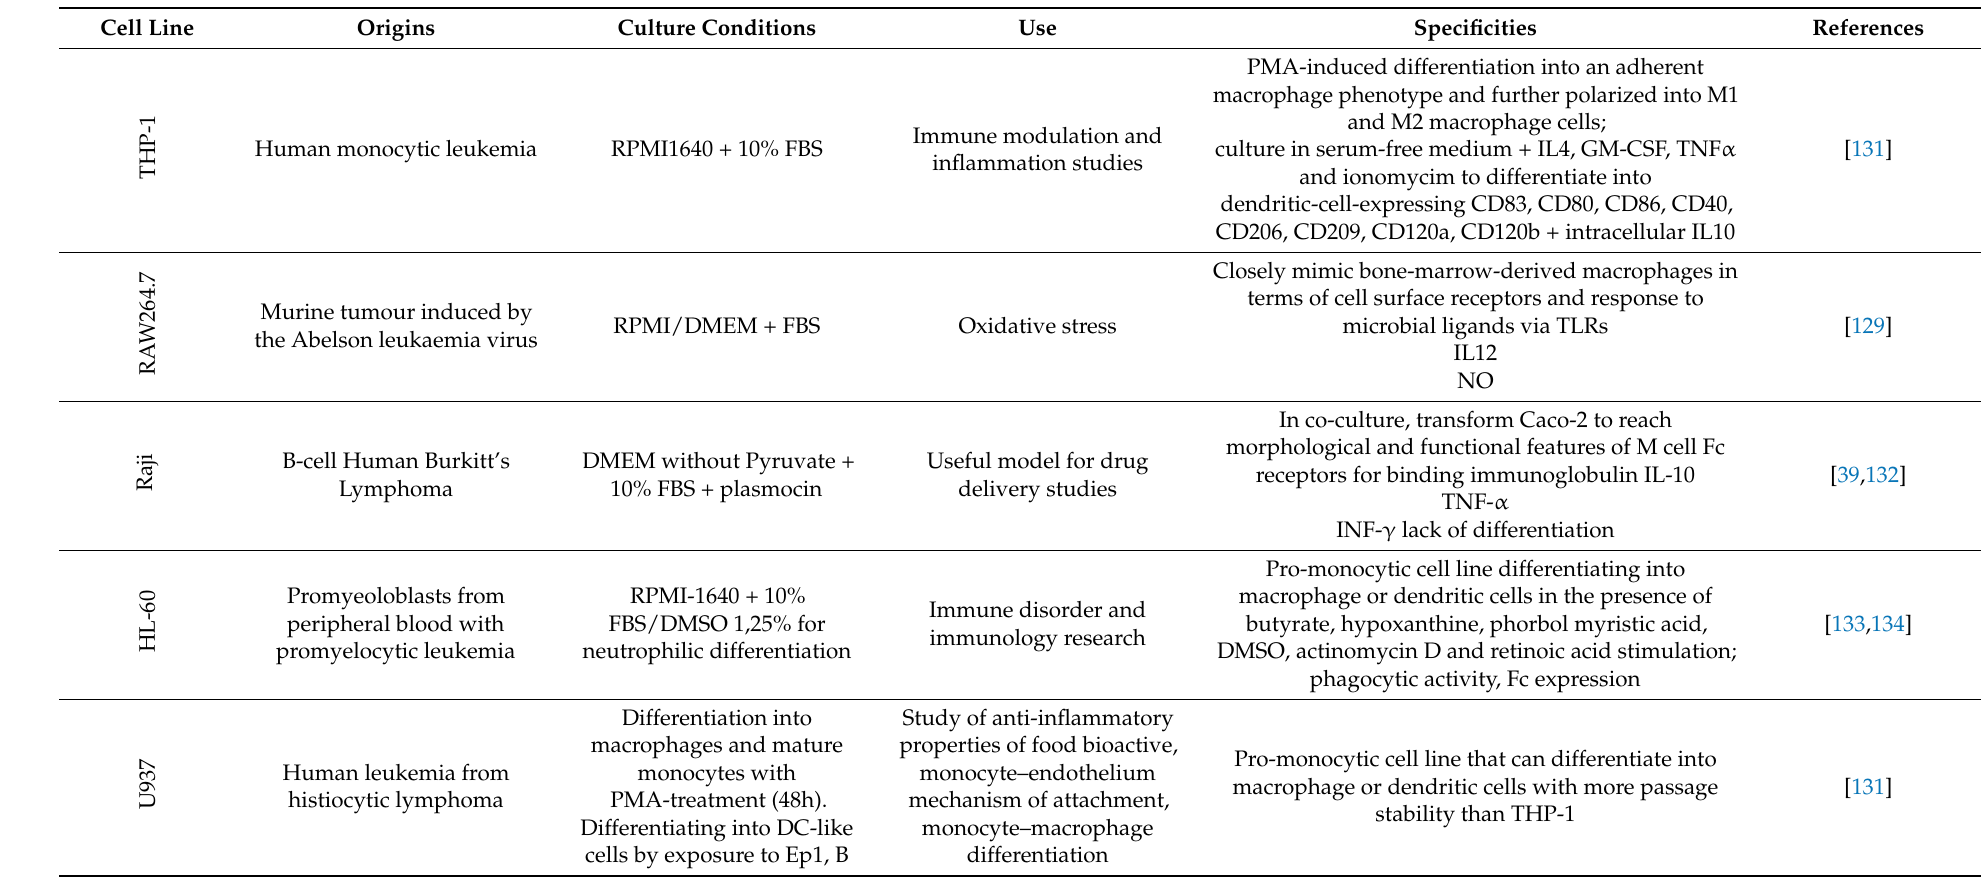
Table 3. Main immune cell